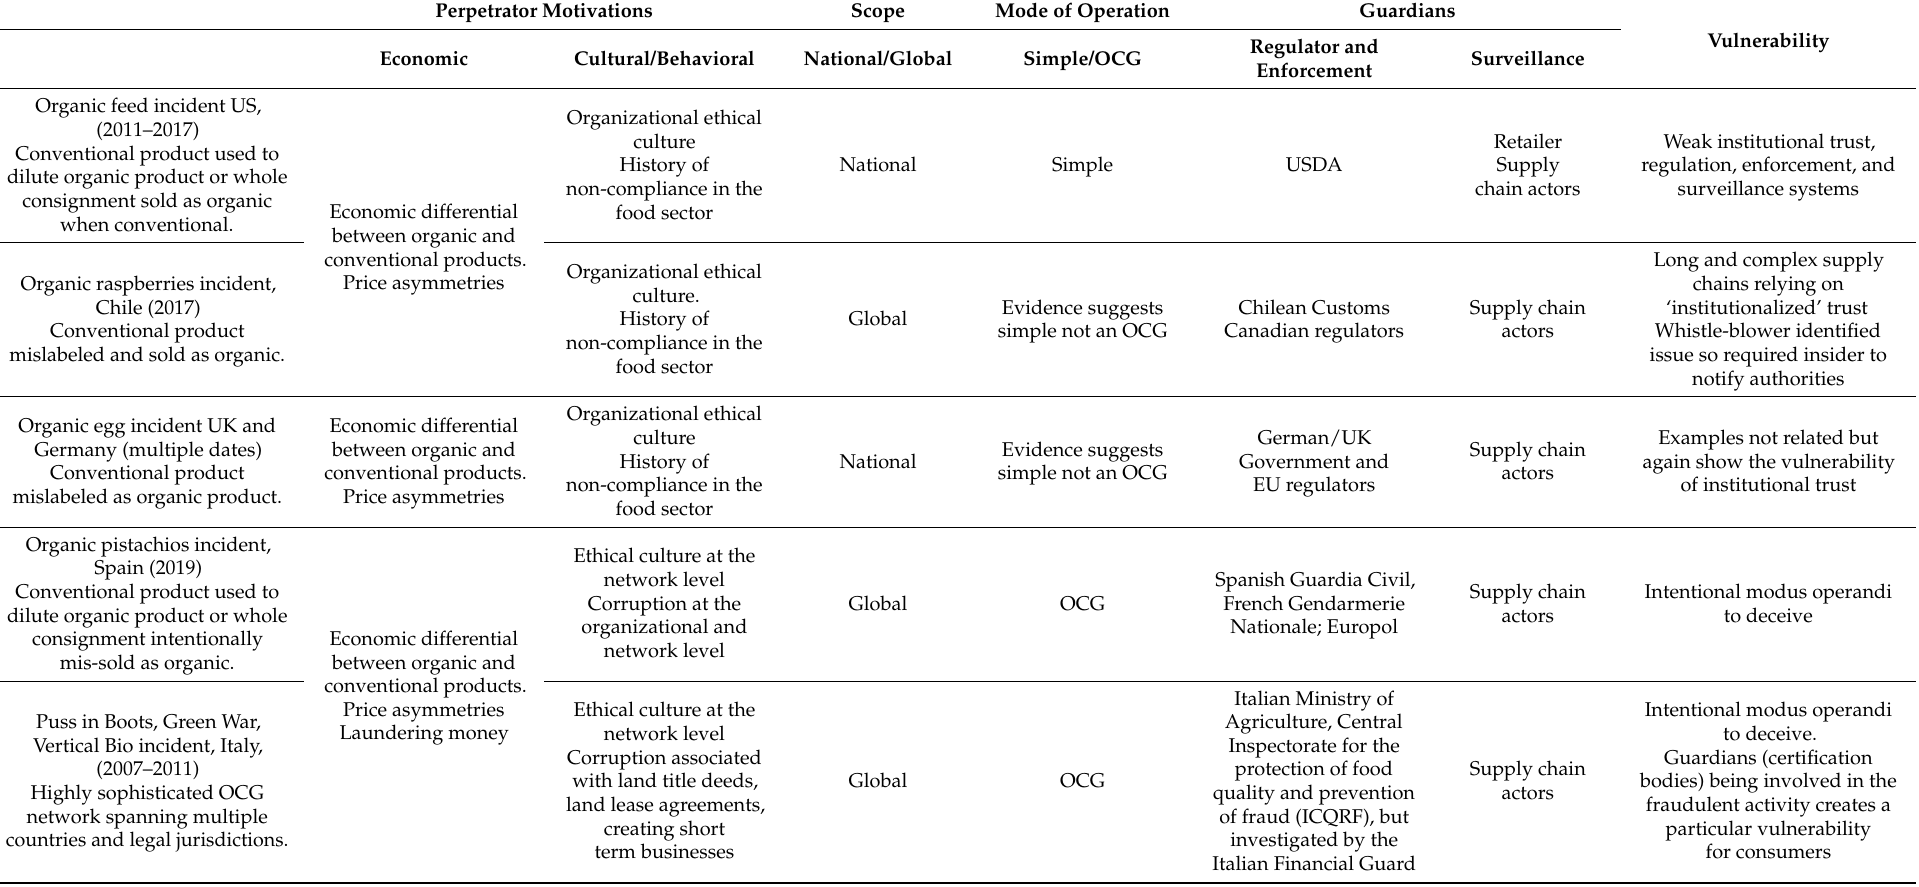
Table 2. Case studies synthesis matrix: motivations, scope, mode of operation, guardians, and